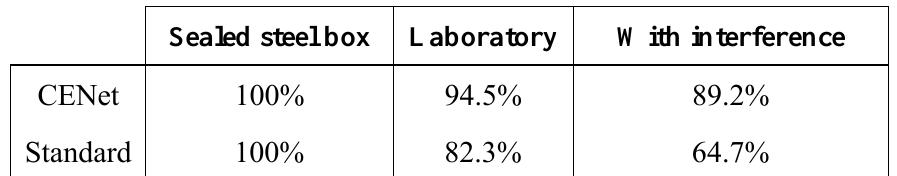
Table 5. The average delivery